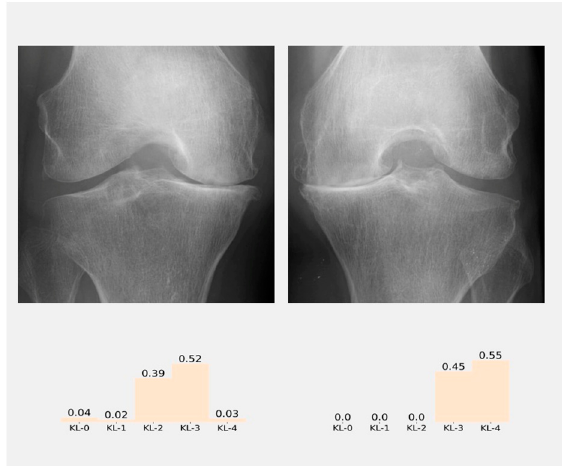
knee of the patient are shown.